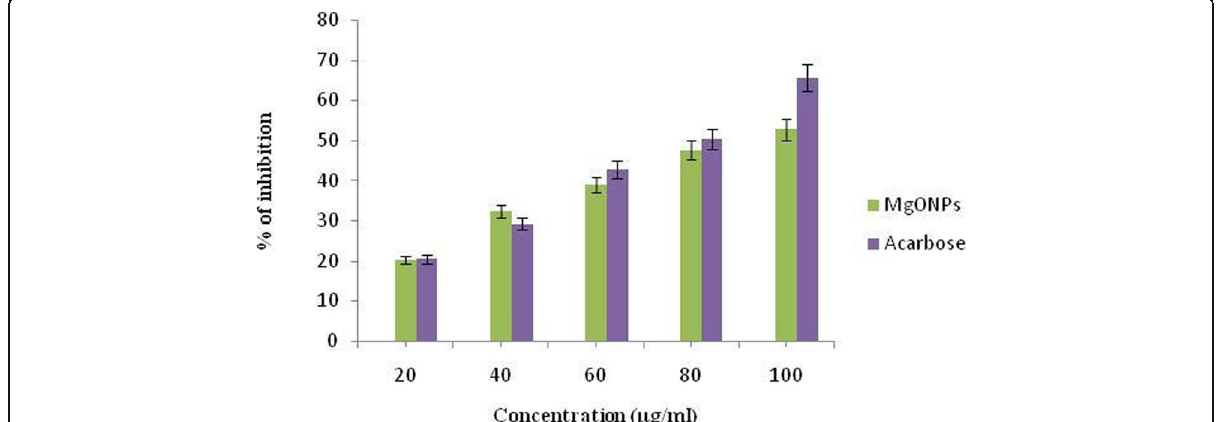
Fig. 9 Representing the percentage inhibition of alpha-amylase by biosynthesized MgO-NPs and Acarbose at different concentrations